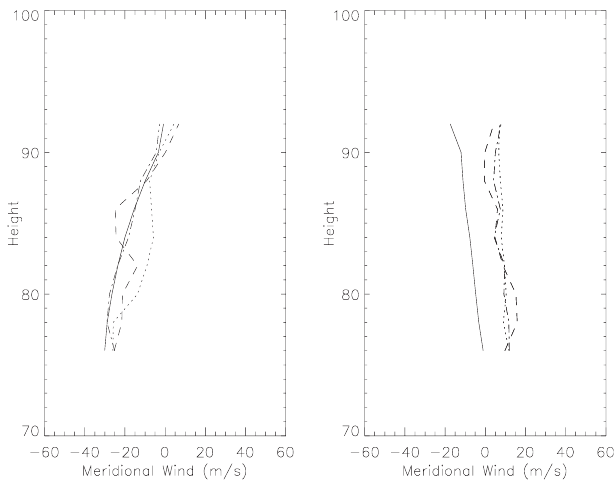
Fig. 4. As in Fig. 3, except for the meridional wind